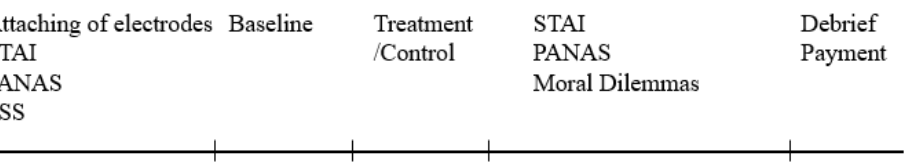
Figure 1. Procedures of the experiment. Note. STAI = State-Trait Anxiety Inventory; PANAS = Positive and Negative Affect Schedule; PSS = Perceived Stress Scale.